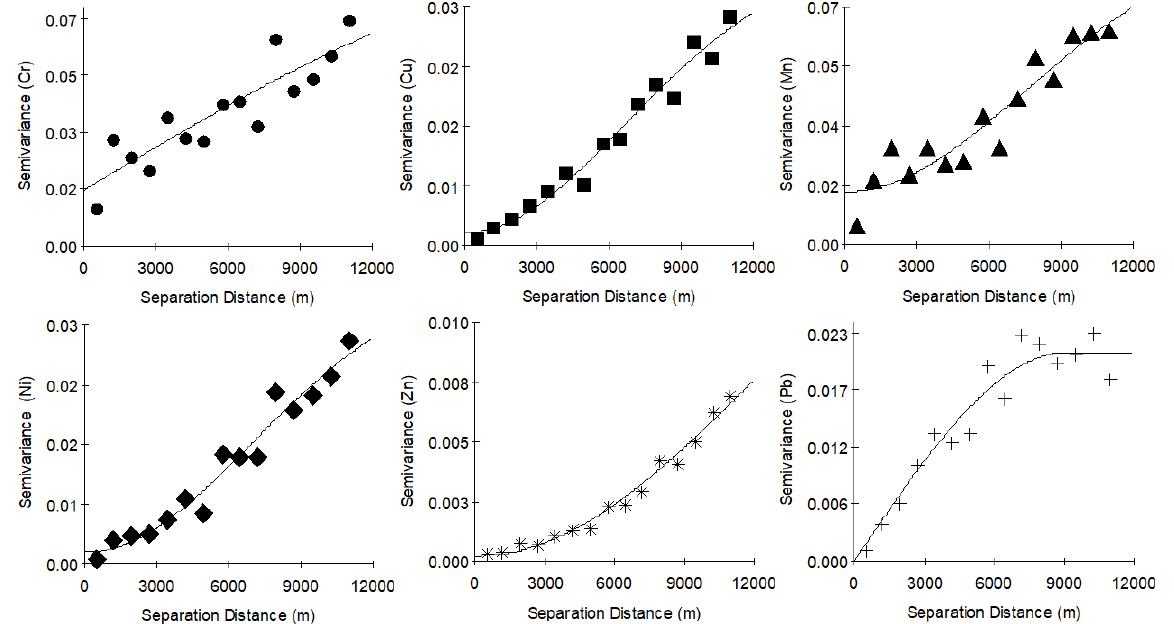
Figure 3. Parameters of the semivariogram model for heavy metal content in surface soil of coal mining area. Table 2. The types of soil heavy